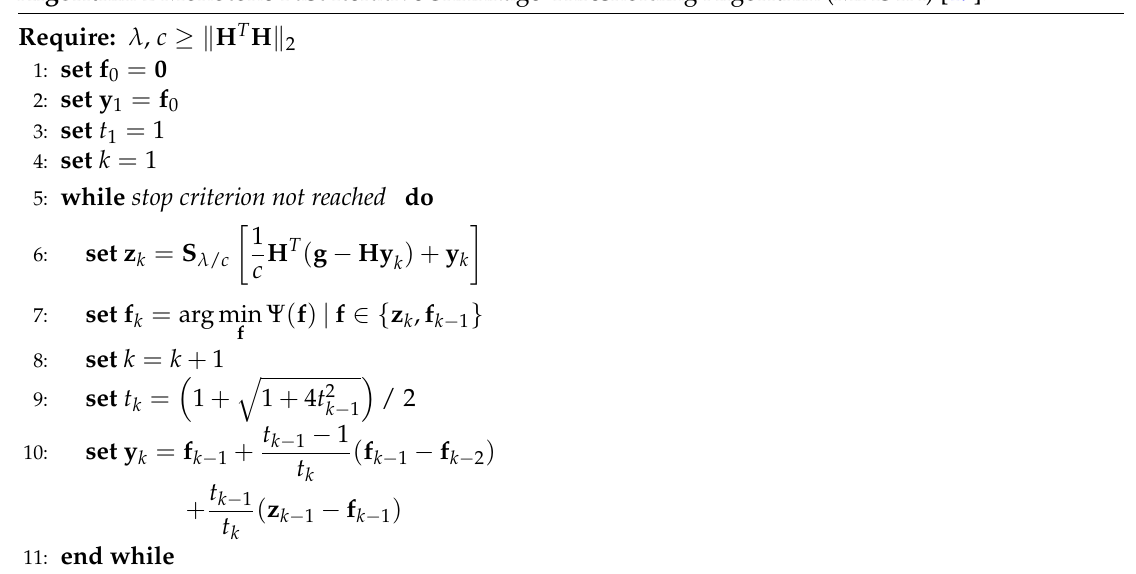
Algorithm 2 Monotone Fast Iterative Shrinkage-Thresholding Algorithm (MFISTA) [19].